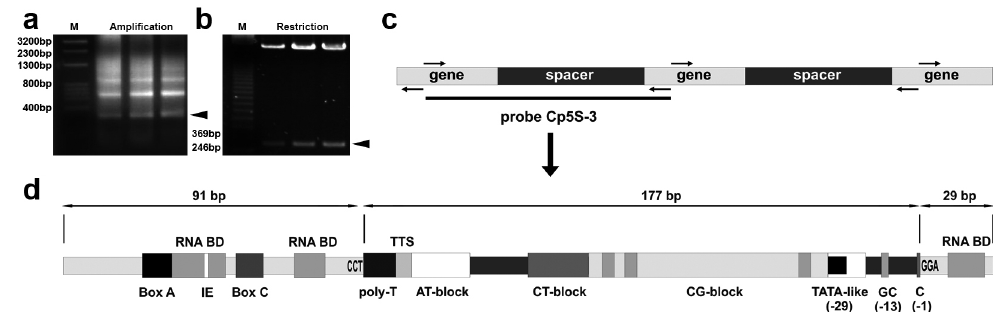
Figure 1 - Development and molecular characterization of the 5S rDNA probe from C. pubescens . (a-b) Gel electrophoresis of the PCR ampli fi cation products and clones, respectively, with that related to the FISH probe marked with arrowheads; (c) Ampli fi cation strategy according to the 5S rDNA unit organization and primers P1/P2 from Park et al. (2000); (d) Core features of the FISH probe Cp5S-3; in the gene, the internal control region (ICR) formed by the motives Box A, Box C and IE (Cloix et al. 2001) and the RNA binding domains (RNA BD) to the TFIIIA (Kellogg and Appels 1995) are shown; additional features correspond to the non transcribed spacer (NTS); TTS, transcription termination